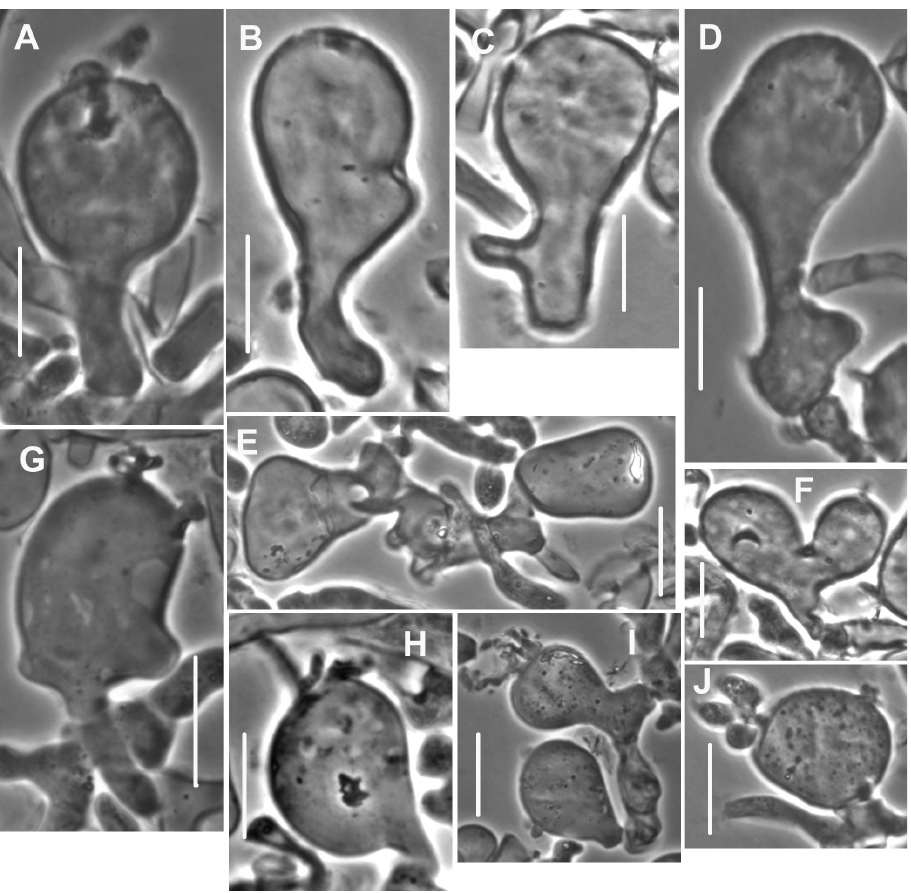
Figure 72. Mycetinis scorodonius . Inflated pileipellis elements. A–F Structures without outgrowths G–J Structures with digitate to lobate outgrowths. Standard bars = 10 µm. TFB 13746 (TENN-F-